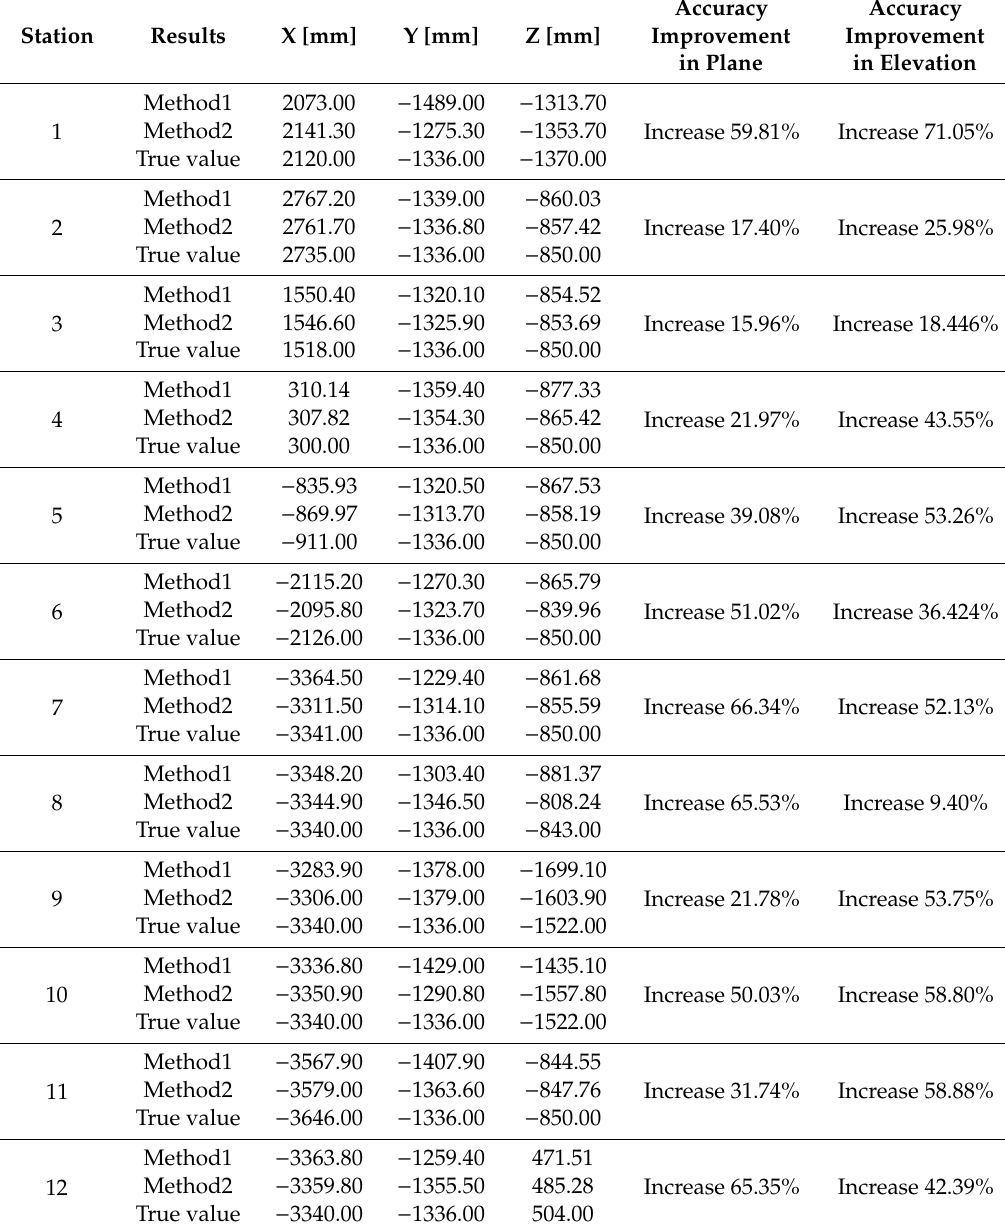
Table 3. Results of experiment